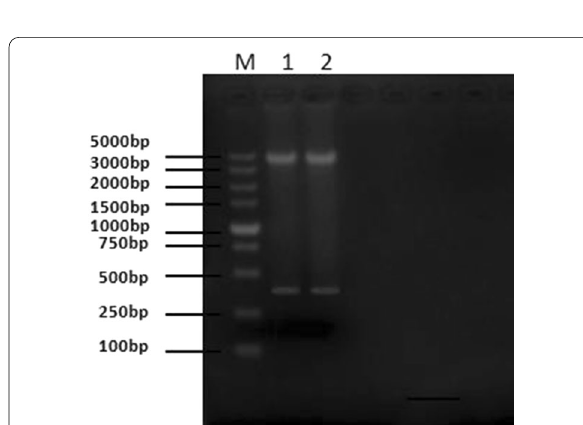
Fig. 6 Recombinant plasmid digestion identification. The plasmids of the positive clones from phage ELISA were isolated, digested with Nco I and Not I, and detected using 1% agarose gel electrophoresis. A target band of approximately 400 bp was obtained